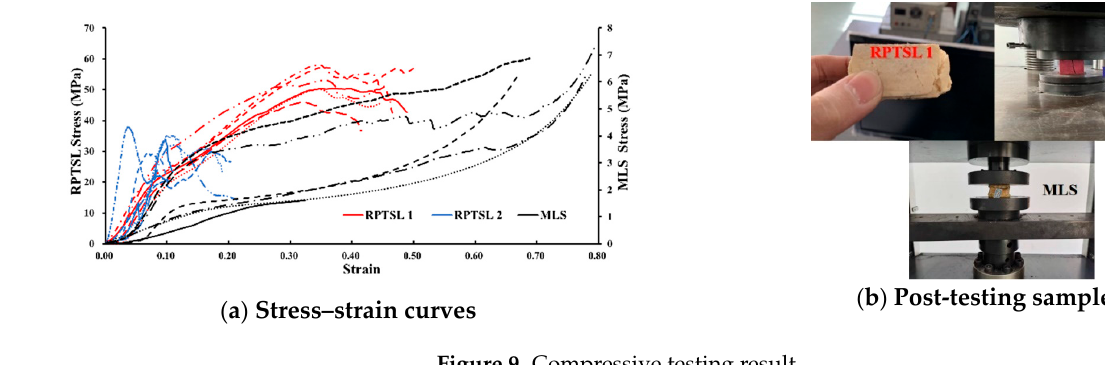
Figure 9. Compressive testing result.